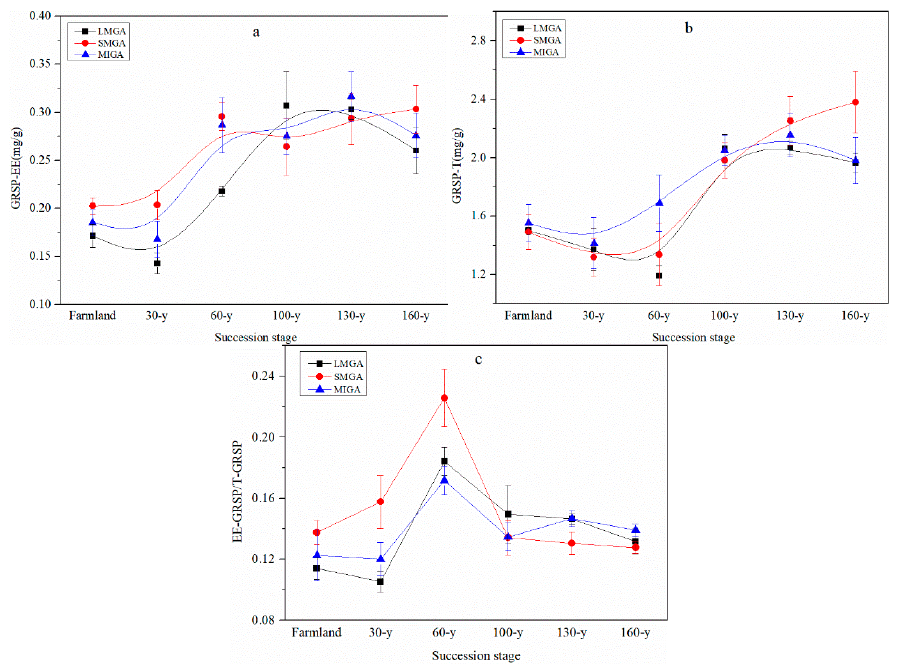
Figure 4. Changes in easily extractable GRSP (GRSP-EE) ( a ), total GRSP (GRSP-T) ( b ), and GRSP-EE/GRSP-T ( c ) in different sizes of soil aggregates with the vegetation succession. Error bars denote Standard error.